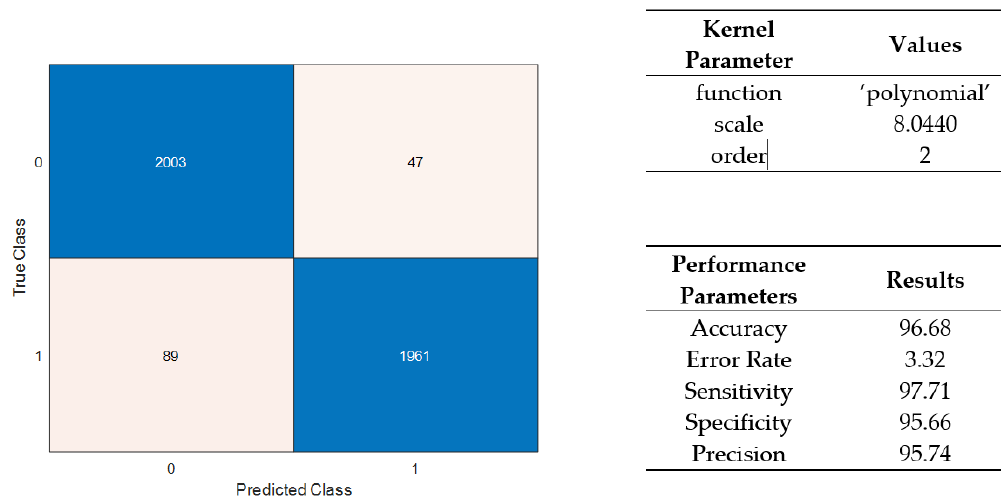
Figure 11. Confusion matrix and performance results for a linear support vector machine (SVM).